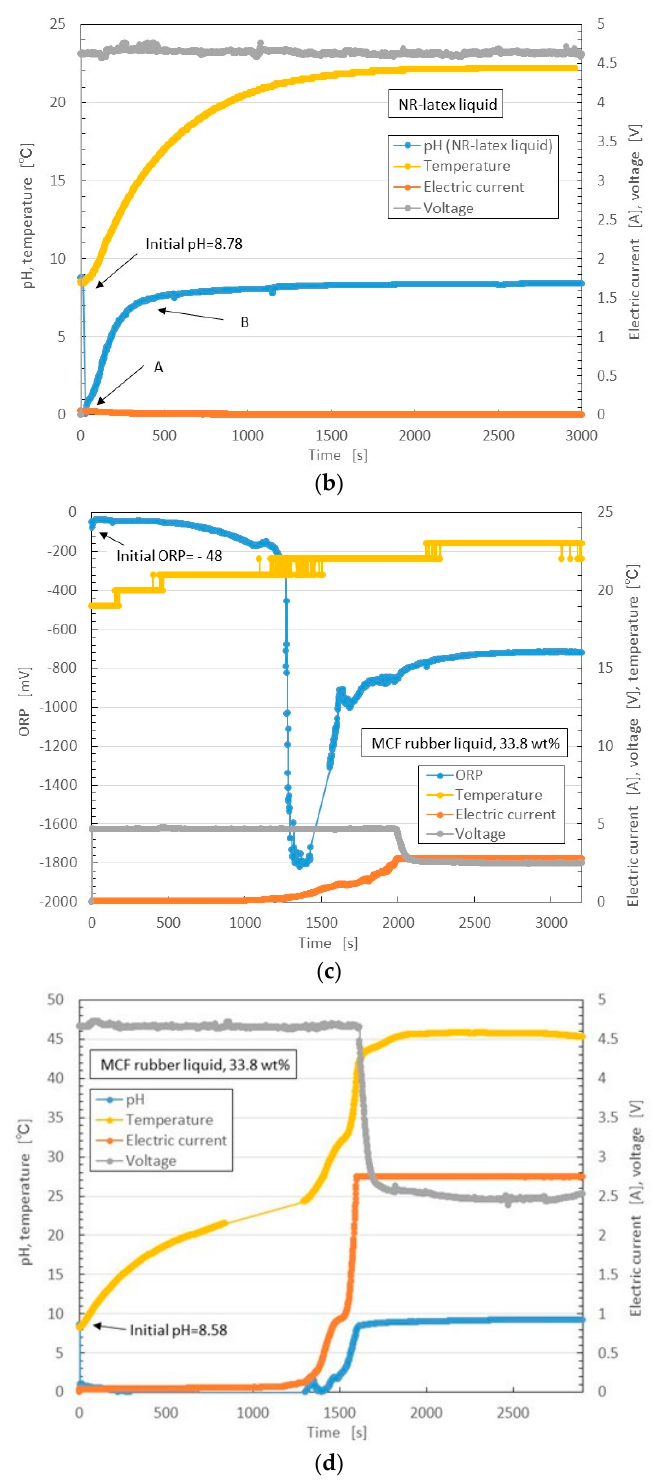
Figure 14. Changes in ORP, pH, temperature, electric current and voltage over time during electrolytic polymerization by the NM: NR-latex liquid in ( a , b ); MCF rubber liquid in ( c , d ). At the initial condition, the quantity of reductant [red] is larger than that of oxidizer [ox]. Therefore, the ORP of the NR-latex liquid is negative, as shown in the initial ORP in Figure 14a. Equation